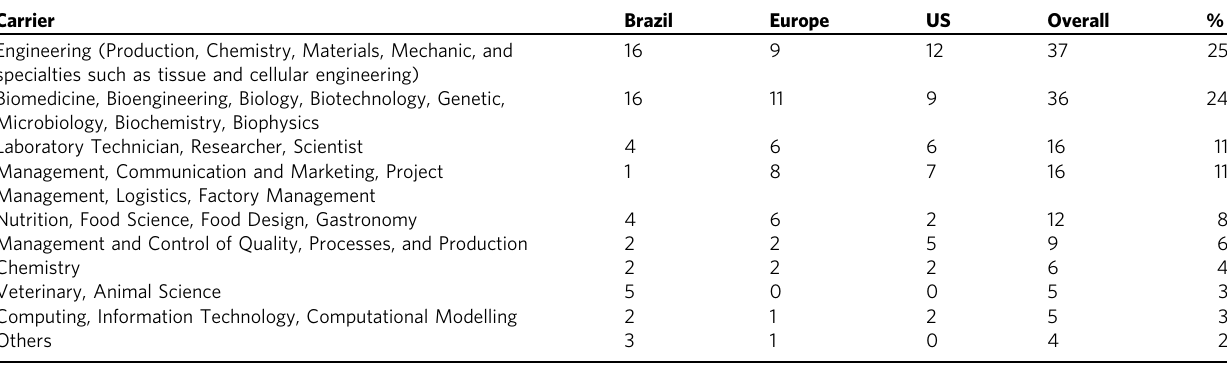
Table 7 Results regarding the most prominent careers which are likely to emerge or strengthen at the fi rst stage of the cultivated meat value chain in Brazil ( N = 26), Europe ( N = 28) and the United States ( N = 23), using an open-ended question.